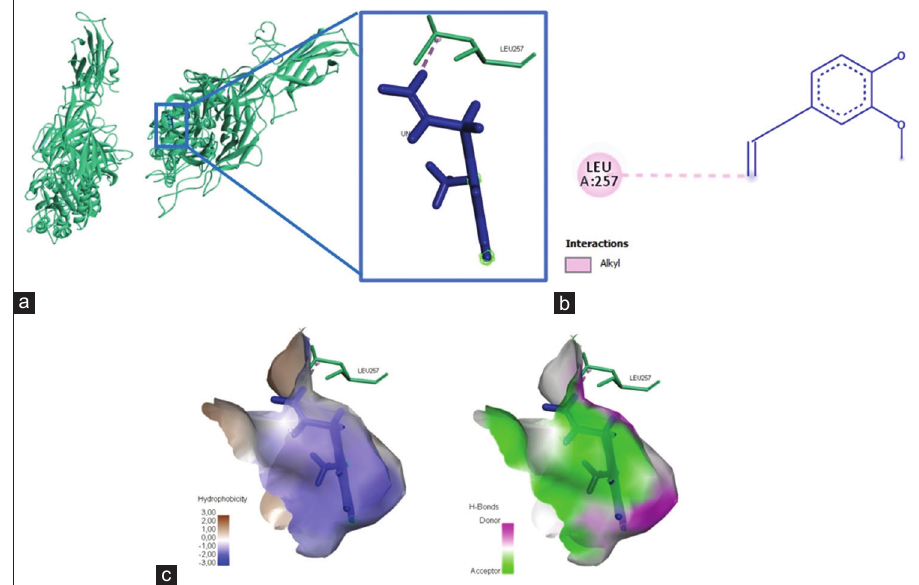
Figure-7: The visualization of the three-dimensional and two-dimensional interaction between phenolic compounds (eugenol) and integrin α 5 β 1. (a) Three-dimensional structural interaction between phenol-ligand eugenol (blue) and integrin α 5 β 1 (green). (b) This interaction is built by alkyl interactions (pink) on the active site of the α 5 β 1 integrin, namely, Leu257, which is seen in the two-dimensional (b) three-dimensional (c)